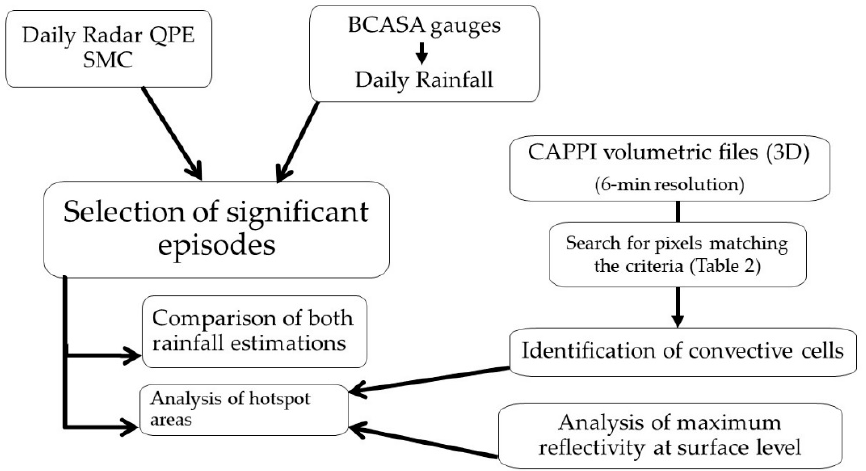
Figure 3. Conceptual scheme of the followed methodology.